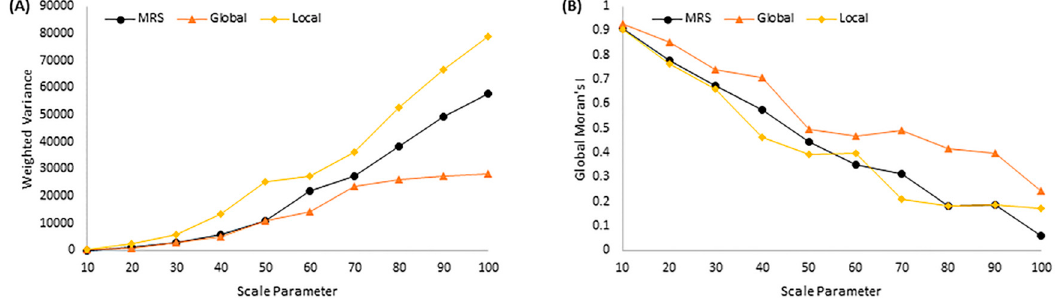
Figure 5. The performance of the three segmentation methods according to the three-band average ( A ) weighted variance ( wVar ) and ( B ) Moran’s I values.